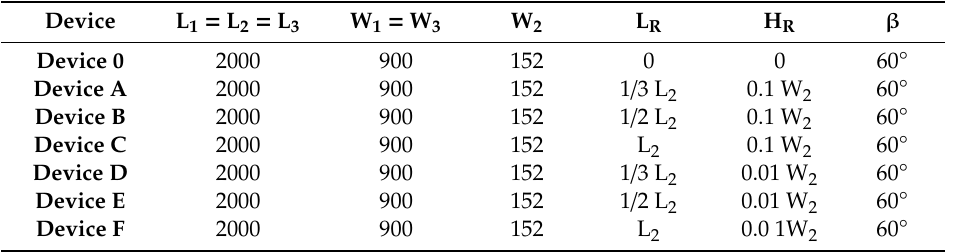
Table 1. Geometrical parameters of all the devices tested (all the values are in µ m except β , which is in